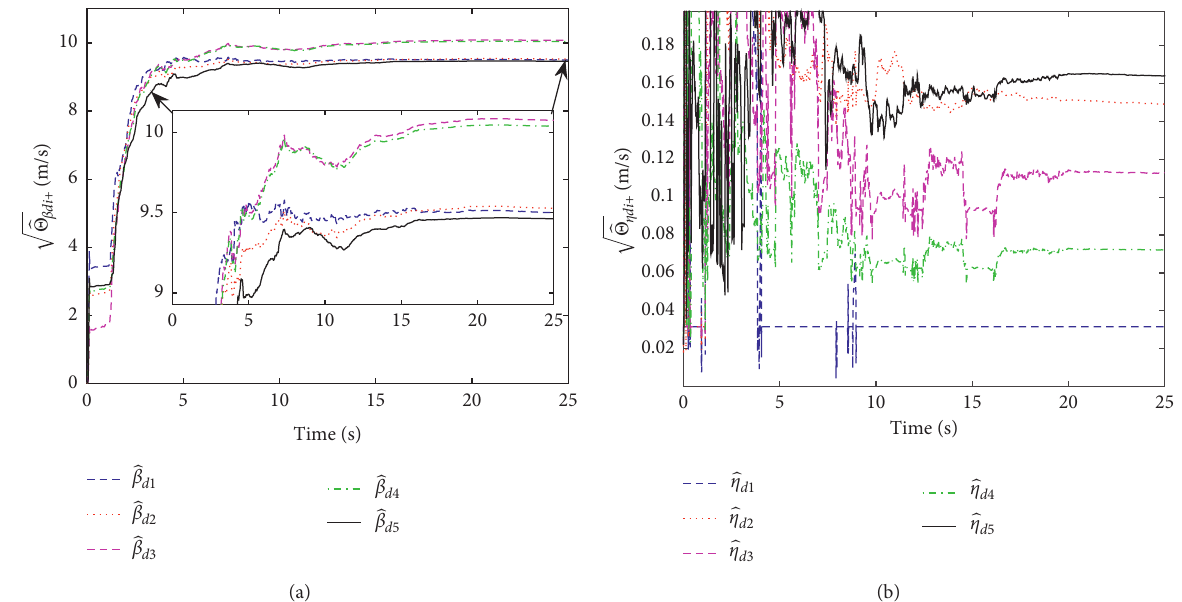
􏽱 ����� 􏽥 Θ . (b) Evolution β di +